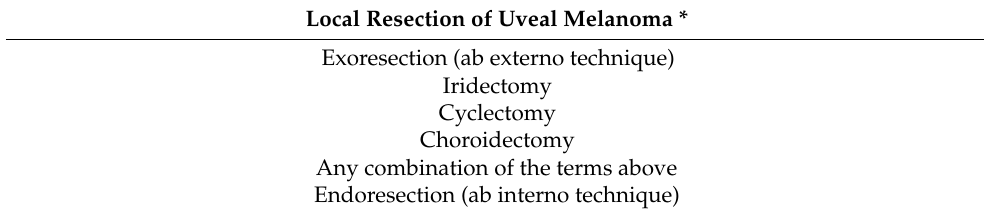
Table 1. Types of local